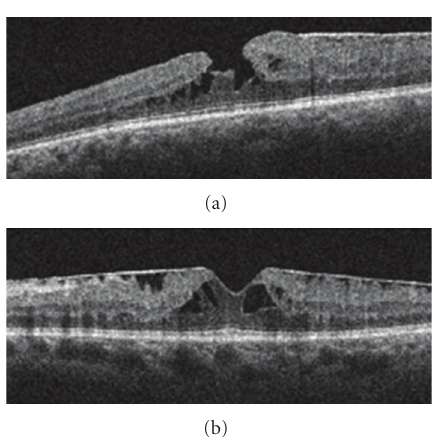
Figure 2: Optical coherence tomography of (a) a lamellar macular hole and (b) an epiretinal membrane with macular pseudohole. Note the di ff erence in foveal contour, as well as intraretinal cysts.